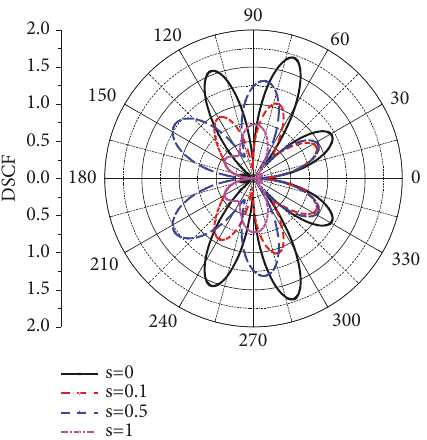
Figure 5: Effect of interface effect on the DSCF with 𝐾 𝐼 /𝐾 = 𝜋